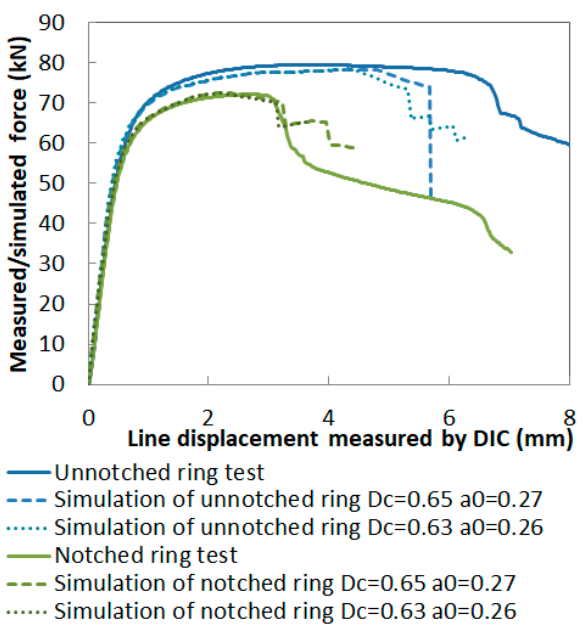
the NCL fracture criterion.